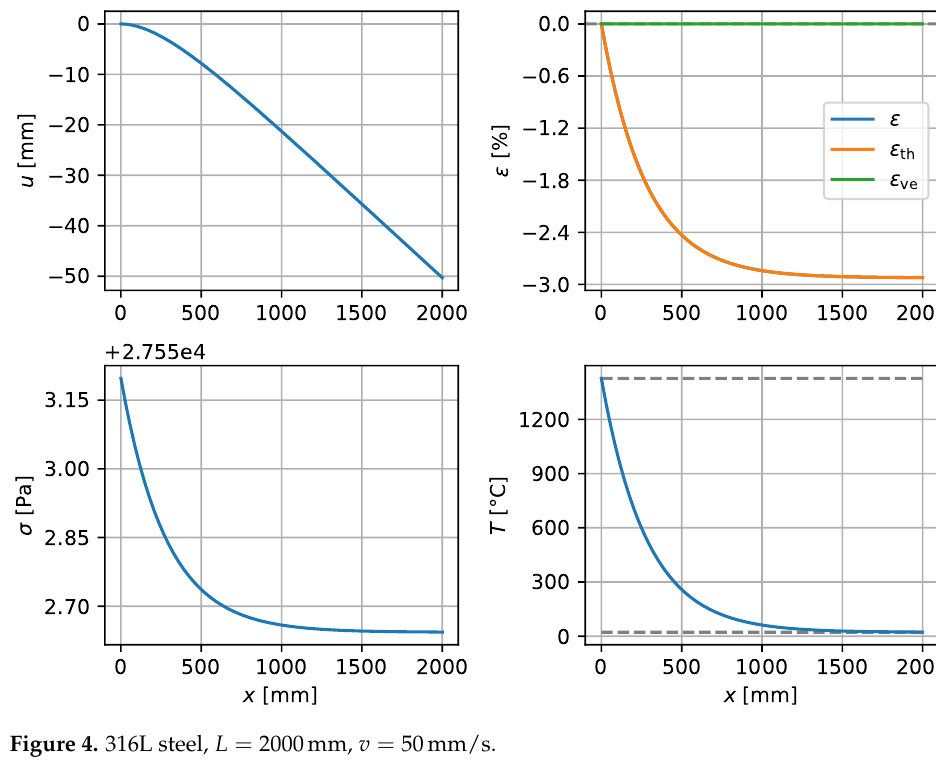
Figure 4. 316L steel, L = 2000mm, v = 50mm/s.